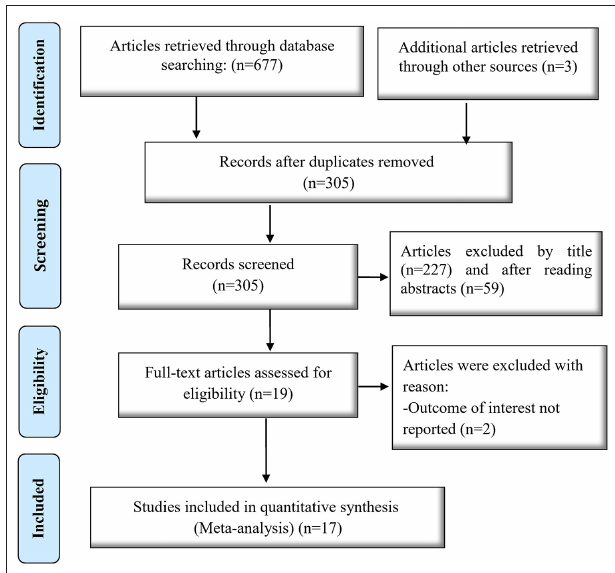
FIGURE 1 | Flowchart of article